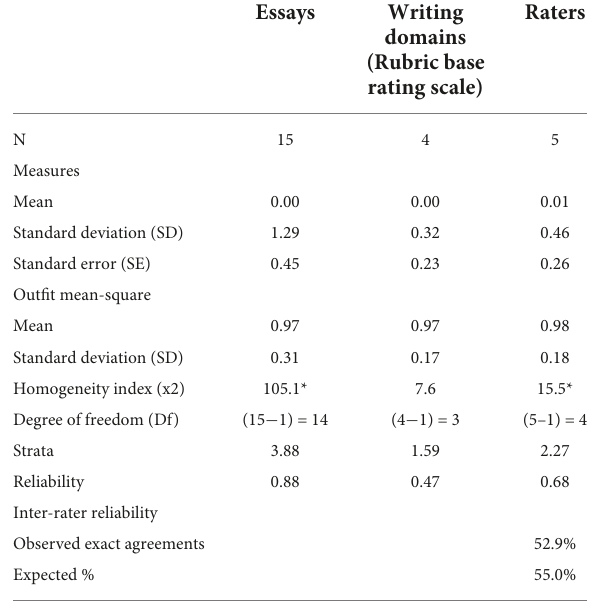
TABLE 4 Analysis of fit statistic for rubric base rating scale.